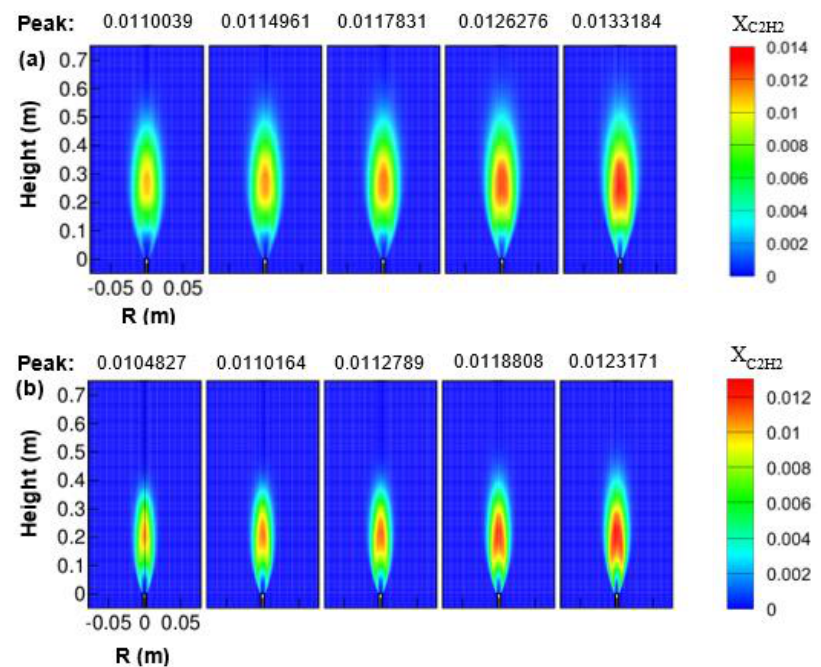
Figure 17. Contours of C 2 H 2 mole fraction varying with air temperature; ( a ) 1 atm, and ( b ) 3 atm.